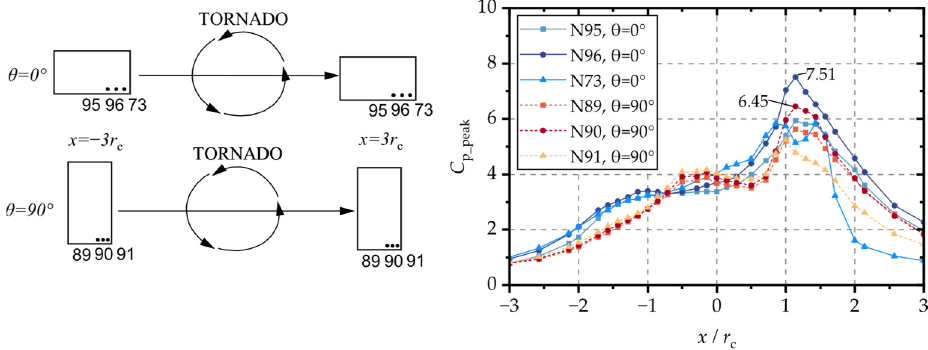
Figure 13. Peak pressure coe ffi cients at certain taps from x = − 3 r c to x = 3 r c .